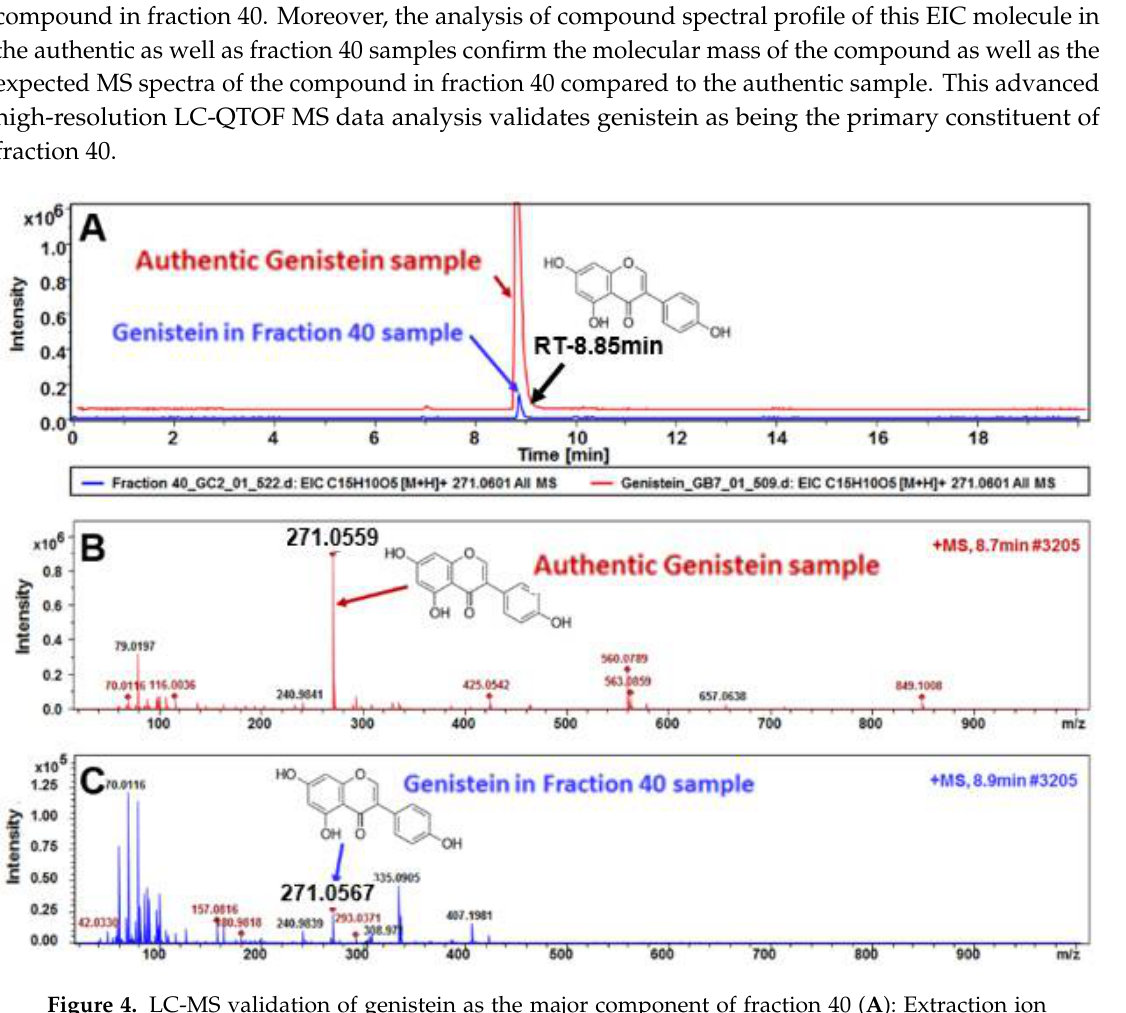
Figure 4. LC-MS validation of genistein as the major component of fraction 40 ( A ): Extraction ion chromatogram (EIC) of authentic genistein sample compared with genistein EIC from fraction 40 reveals a perfect retention time (RT) match at around 8.85 min, as expected, confirming the correct identification of the compound. ( B , C ): The compound spectra of authentic genistein ( B ) and genistein in fraction 40 ( C ) are depicted. The [M + H] = 271.055 ± 0.001 m / z of the identified compound is the same with that of the authentic genistein. The data profile analysis ( A – C ) depicts a representation of six replicates with high confidence of reproducibility.